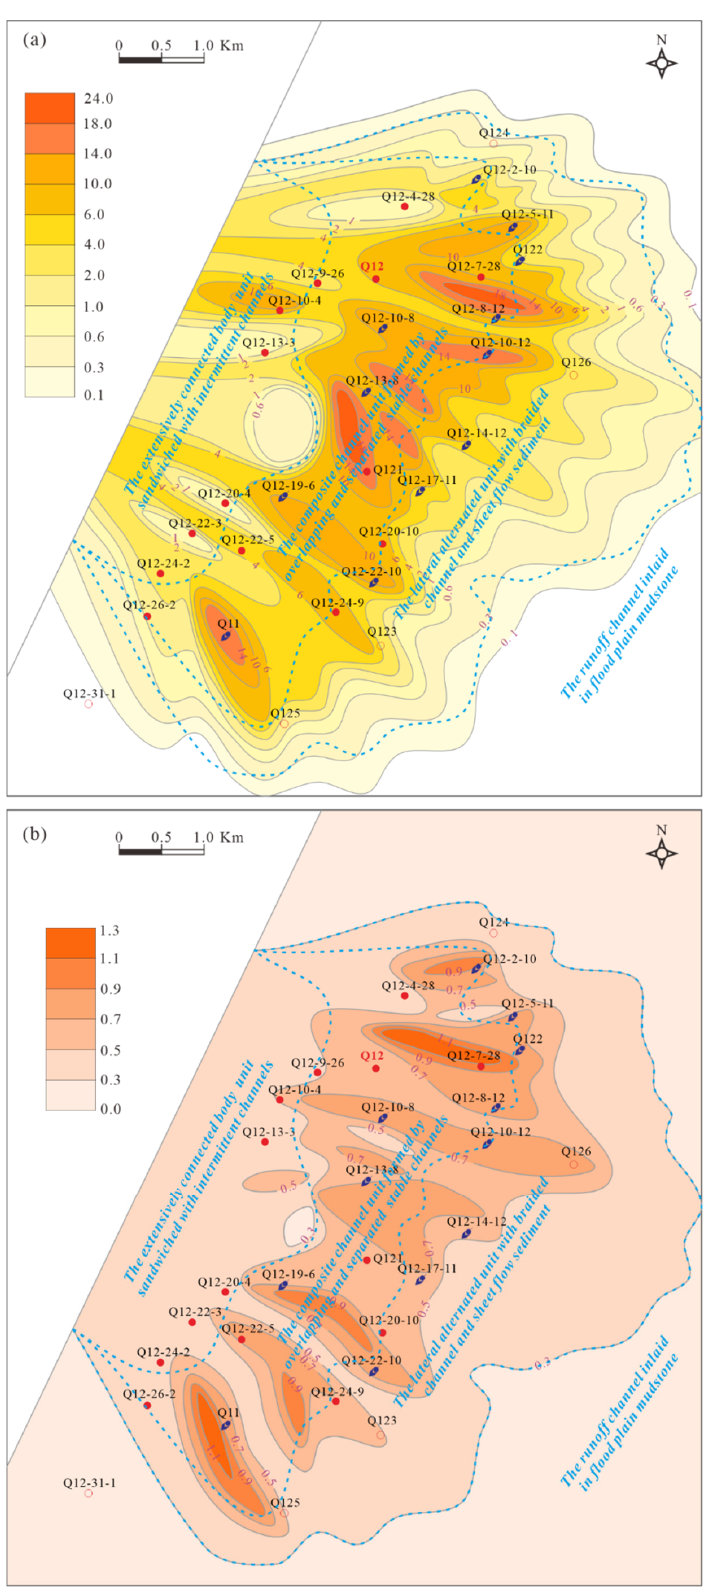
Figure 9. ( a ) Permeability and ( b ) variation coefficient distribution of the E31 ‐ IV ‐ 4 formation in the Qie12 block.